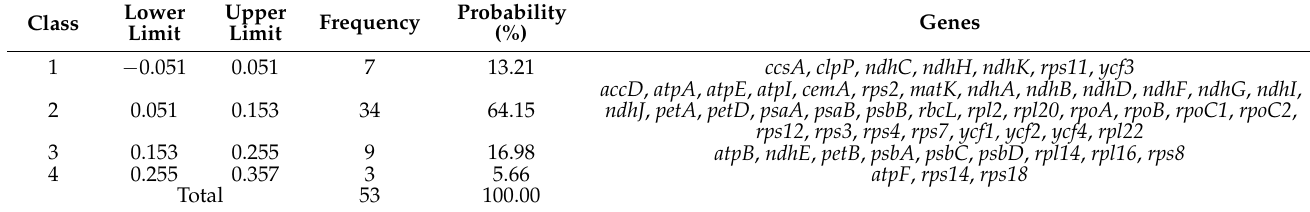
Table 5. Frequency distribution of the ENCratio of the chloroplast genome of oil-tea